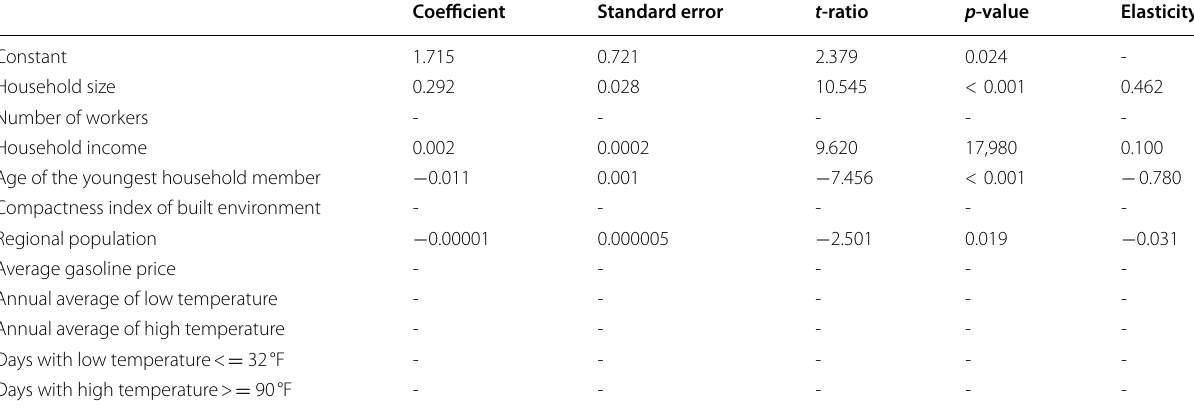
‘-’ This variable is not statistically significant at 0.1 level Pseudo-R2: